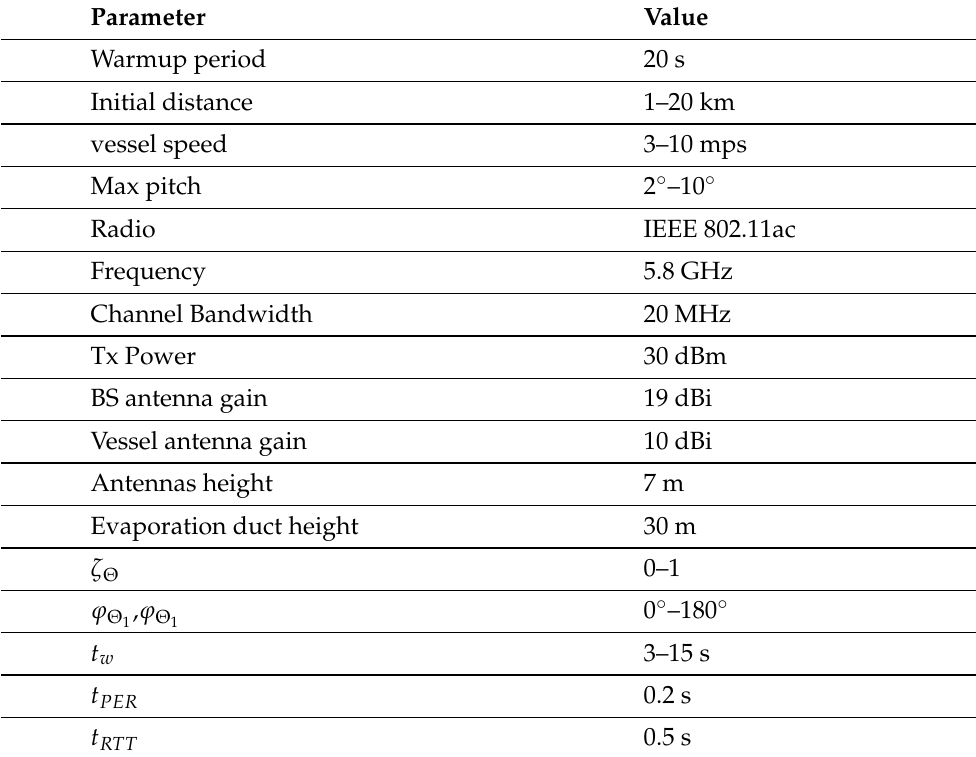
Figure 12. The average TCP throughput for different propagation models. Table 2. Simulation